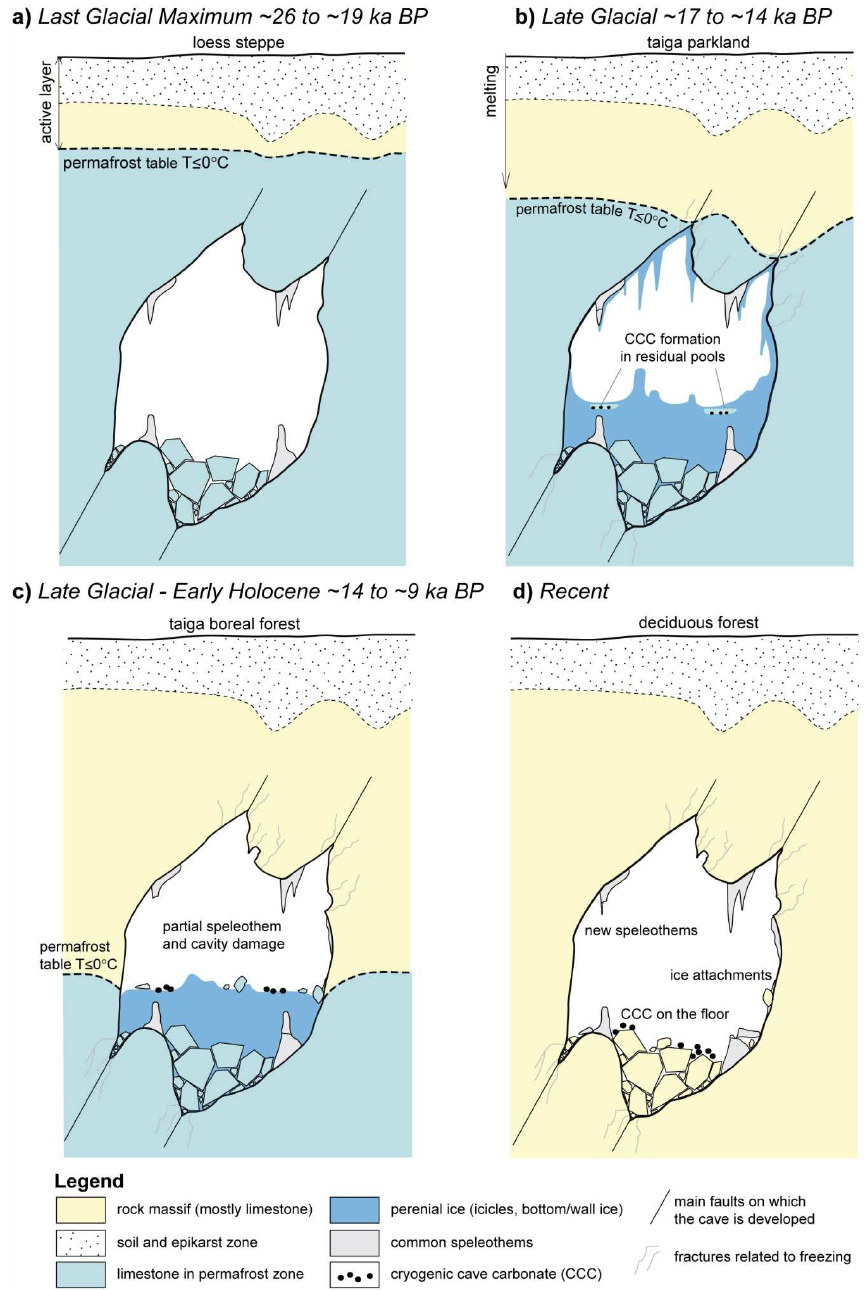
Fig. 5. A model of formation of coarsely crystalline CCC during a single permafrost destruction (thawing) after the Last Glacial Maximum. See text for further details.